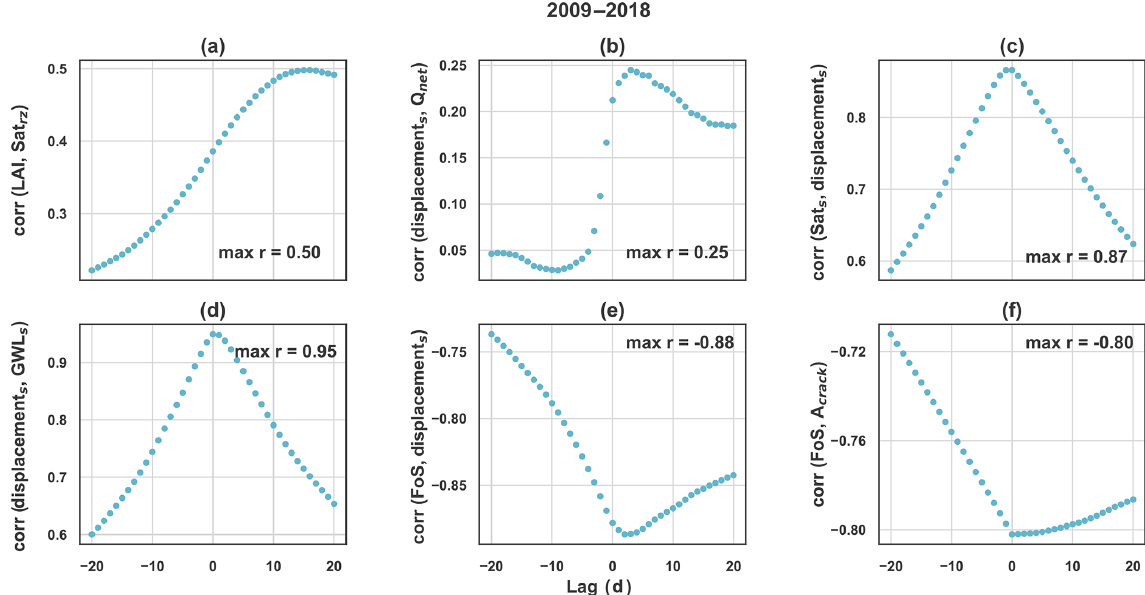
Figure 4. Correlation coefficient ( r ) between two parameters with time lags between − 20 and 20d during ten years of